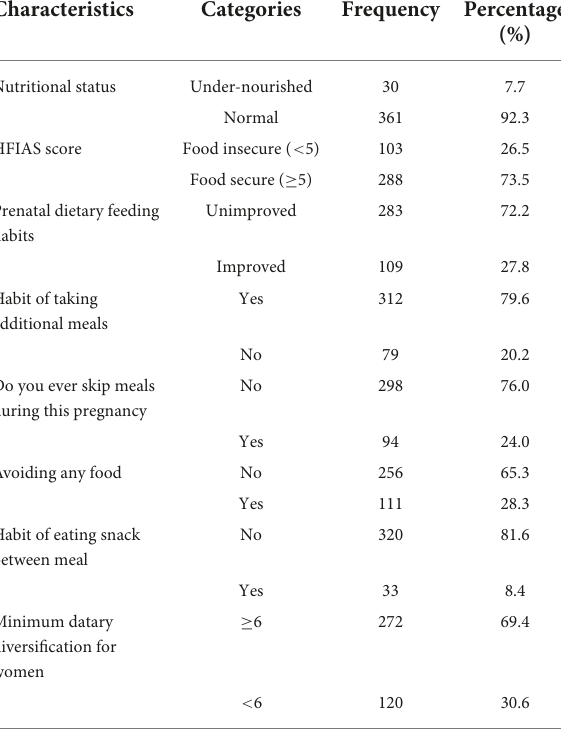
TABLE 4 Dietary characteristics of pregnant women living in Liban District ( n = 420),